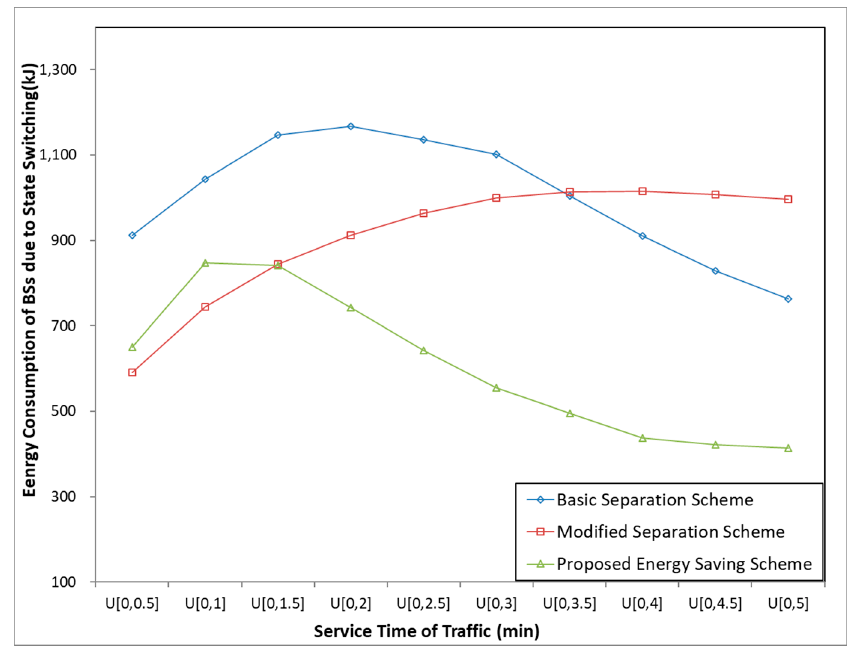
Figure 18. Energy consumption of BSs due to state switching. Energies 2017 , 10 , 1417